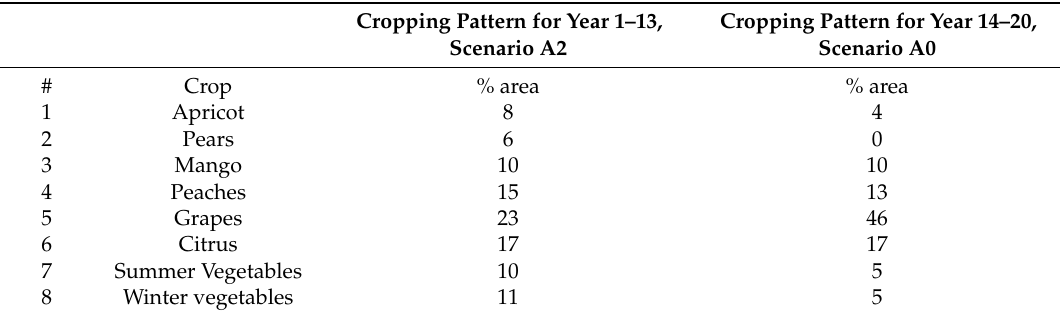
Table 2. Cropping Patterns under Scenario A2 and